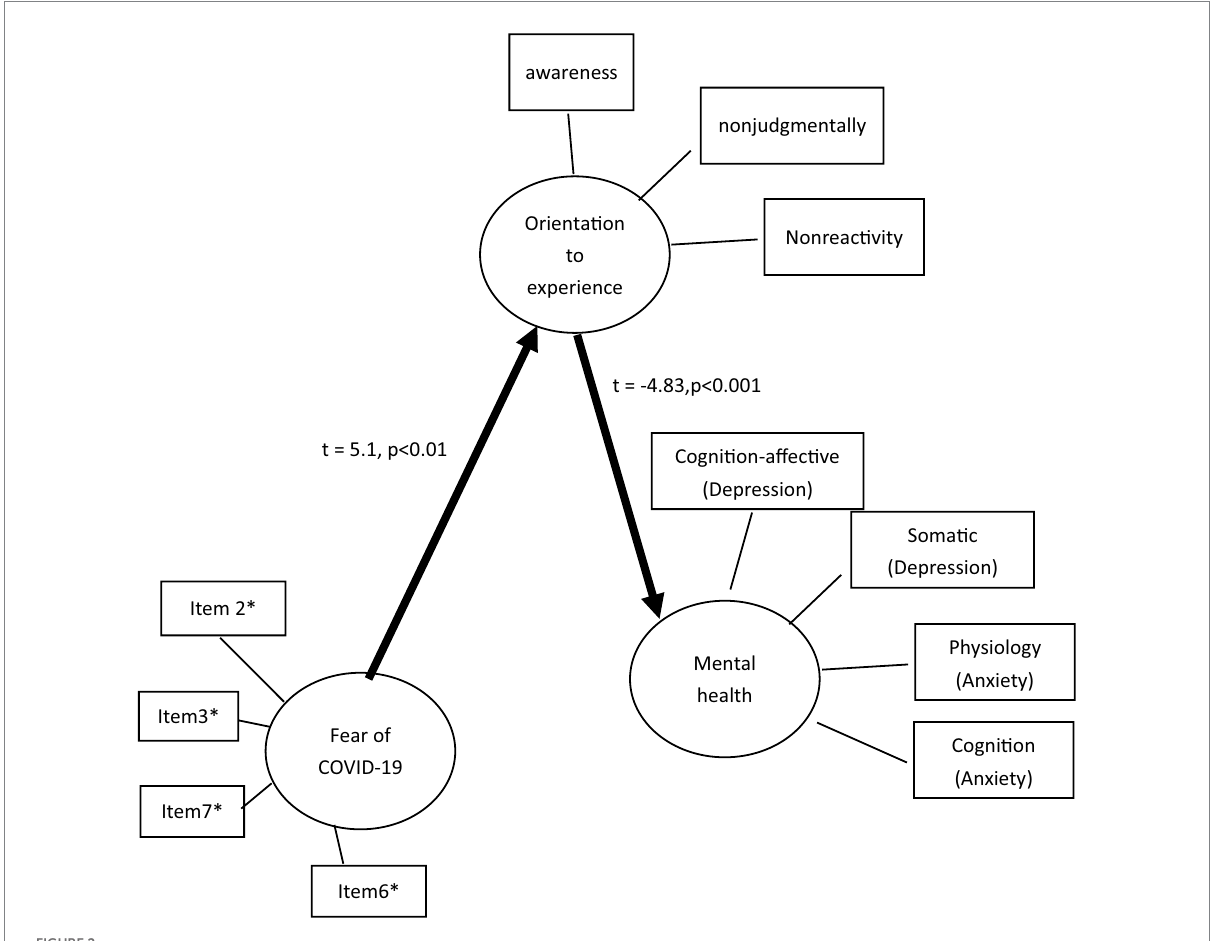
FIGURE 2 The coefficients of the revised hypothesized model. *Item 2: It makes me uncomfortable to think about coronavirus-19. *Item3: My hands become clammy when I think about coronavirus-19. *Item6: I cannot sleep because I’m worrying about getting coronavirus-19. *Item7: My heart races or palpitates when I think about getting